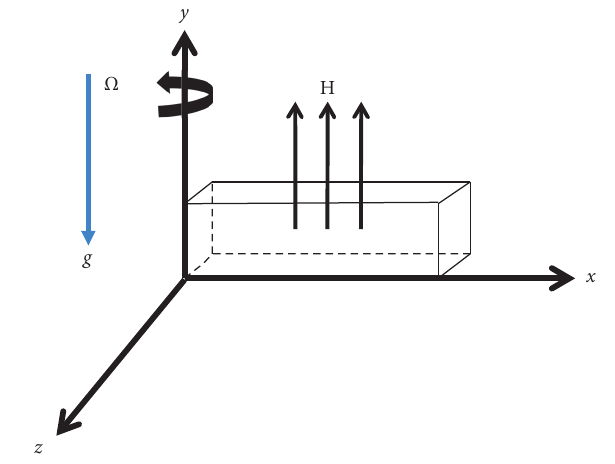
Figure 1: Schematic of the